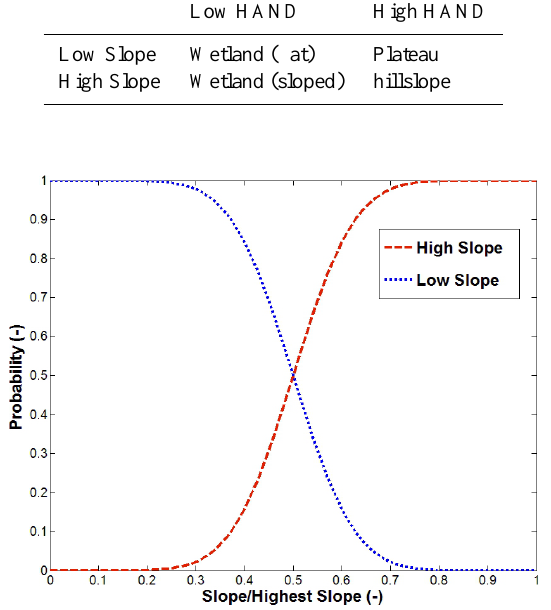
Fig. 3. An example of fuzzy classification for high and low slope. In the central part of the graph the classification is uncertain while at the extremes the uncertainty is